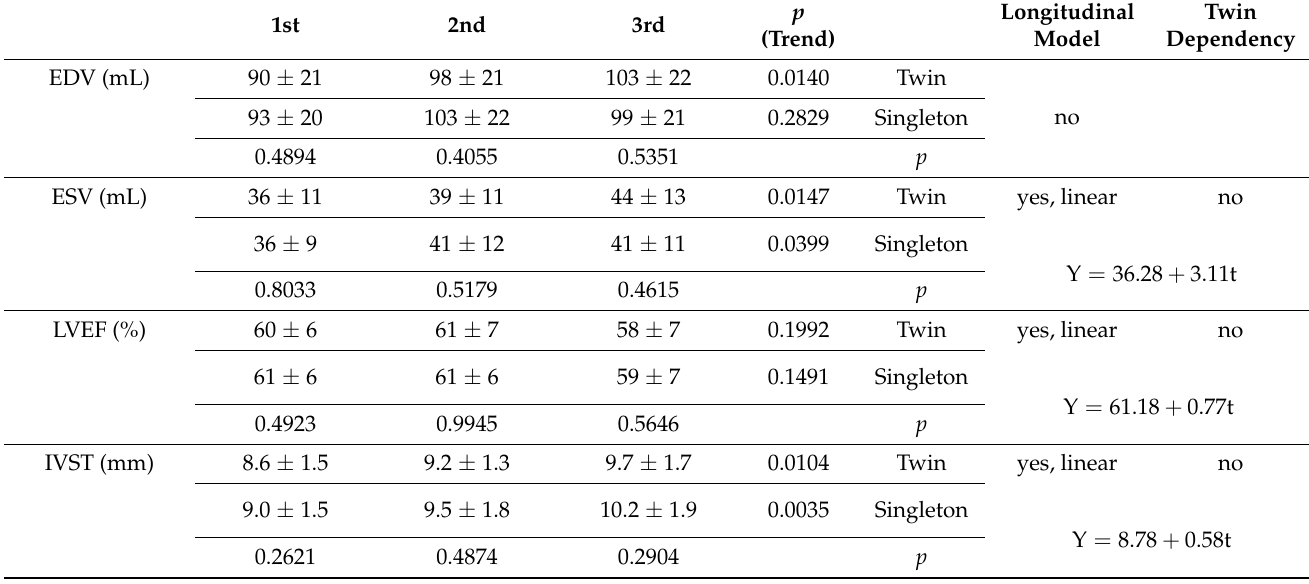
Table 2. Left ventricular findings obtained by conventional and speckle-tracking echocardiography at each trimester in twin versus singleton